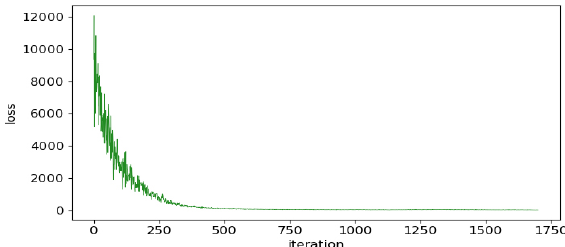
Figure 5. Training process. The loss convergences to a very small value after 500 training